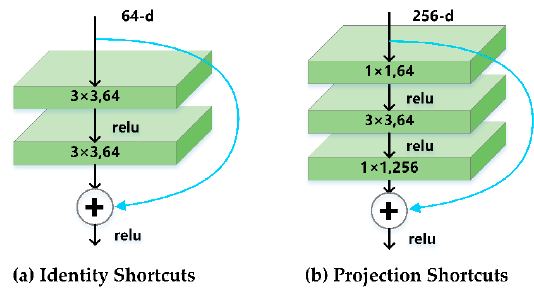
Figure 6. Shortcut Figure 6. Shortcut connections.